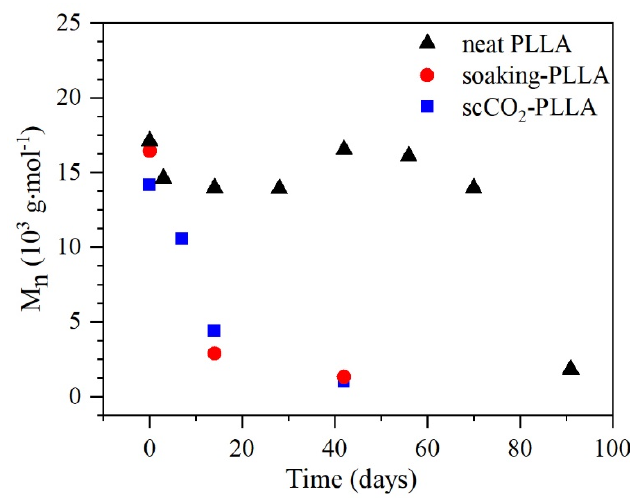
Figure 7. M n of PLLA during the in vitro degradation experiment.